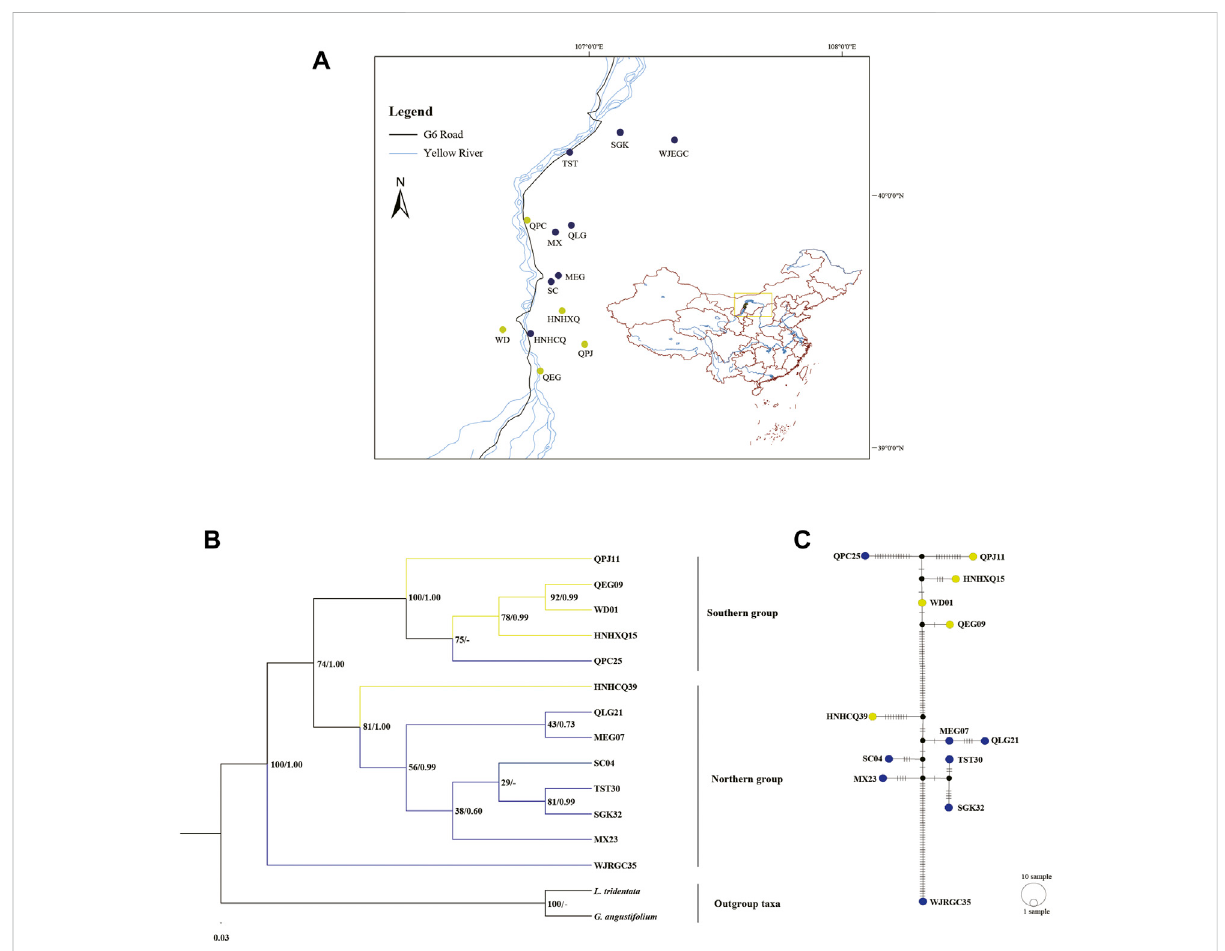
FIGURE 6 (A) Geographical distributions of sampled T. mongolica populations. (B) The ML tree of 13 T. mongolica inferred from complete chloroplast genomes. Numbers at nodes represented the bootstrap support values and posterior probability values. Dash ( – ) denoted this relationship was